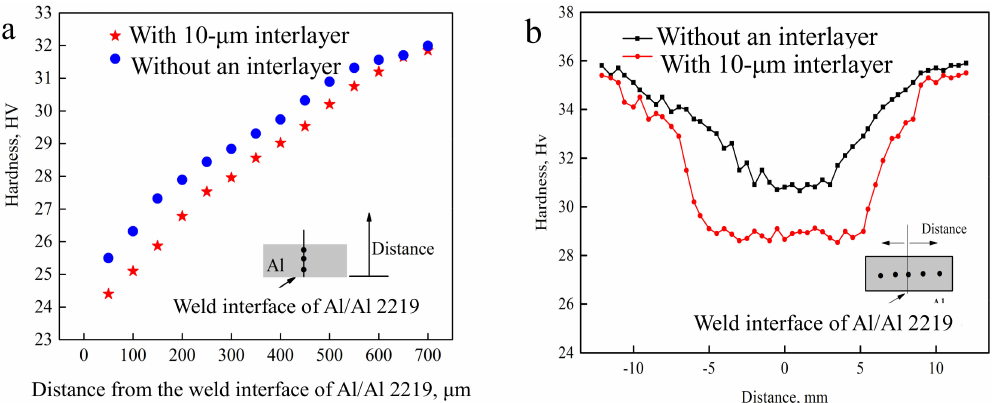
Figure 11. Vickers characteristic microhardness profiles of the Al side in the USWed joints with different thicknesses of interlayers; ( a ) vertical in the weld center; ( b )